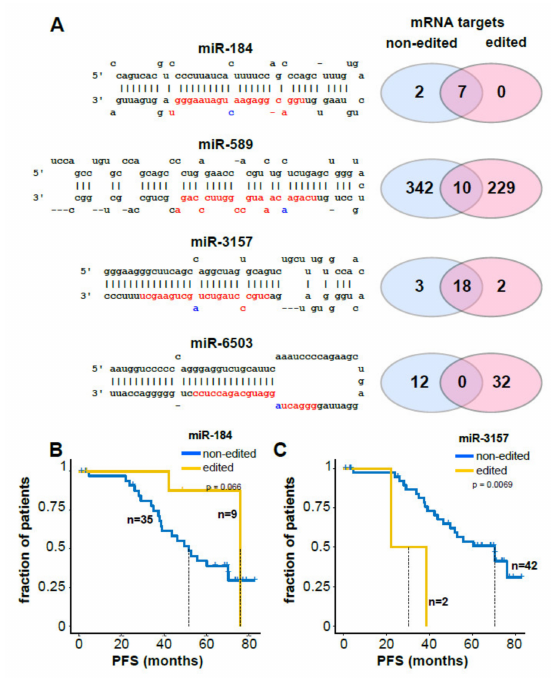
Figure4. SignificanceofmiRNAeditinginCLL.( A )SequencesofeditedmiRNAsareshown. Themature miRNAisshowninredwiththeeditedbaseindicatedinblue. Thenumbersofpredictedhigh-confidence mRNA targets for edited and non-edited miRNAs are indicated by Venn diagrams. ( B ) Progression free survival (PFS) of 44 CLL patients with or without edited miRNA-184. ( C ) Progression free survival (PFS) of 44 CLL patients with or without edited